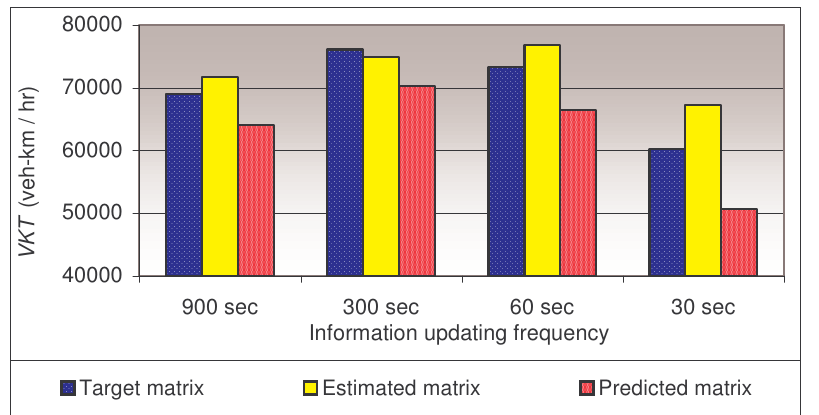
Figure 4. Changes in the VKT (veh-km/hr) for different information updating frequencies and loading